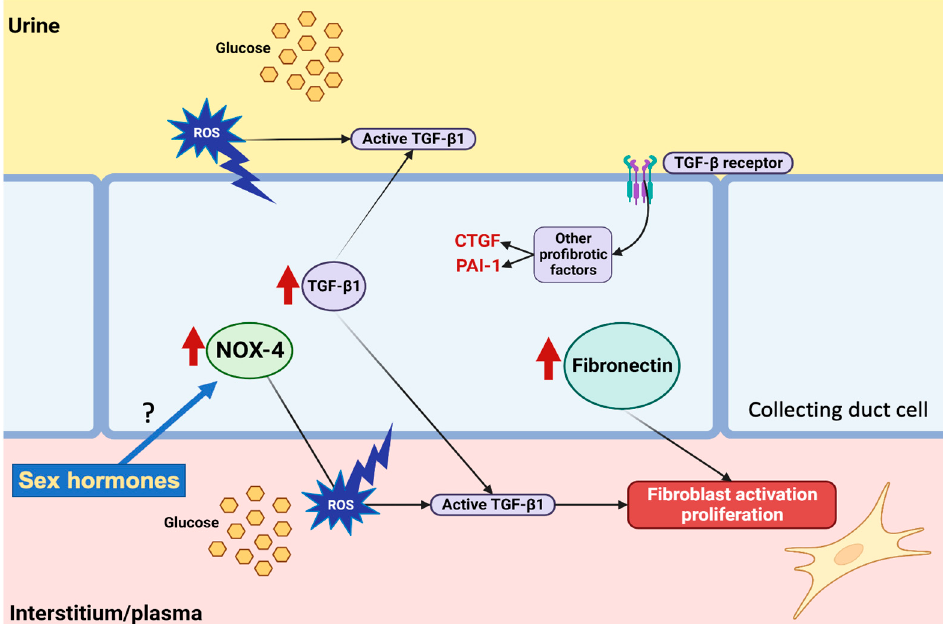
Figure 10. Hypothetical pathways involved in the regulation of reactive oxygen species (ROS) production under high glucose conditions. Hyperglycemia and glucosuria promotes auto-oxidation of glucose to form free radicals in collecting duct cells. In vivo data showed that NOX-4 is upregulated in females but not in males. TGF- β 1 and fibronectin were increased in vivo and in vitro in collecting duct cells. Experiments on M-1 collecting duct cell line demonstrated that NOX-4 contributes to ROS production under high glucose conditions. Activation of the TGF- β 1 receptor further promotes induction of other profibrotic factors such as CTGF and PAI-1, while fibronectin enhances fibroblast activation and fibroblast proliferation. Figure created with BioRender.com (BioRender’s Academic License BJ24Y7RW2L).